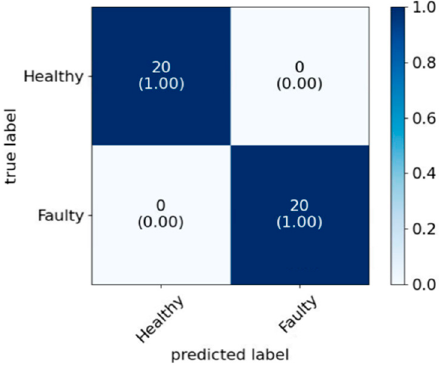
Figure 12. Model 3—confusion matrix for engine misfire data.